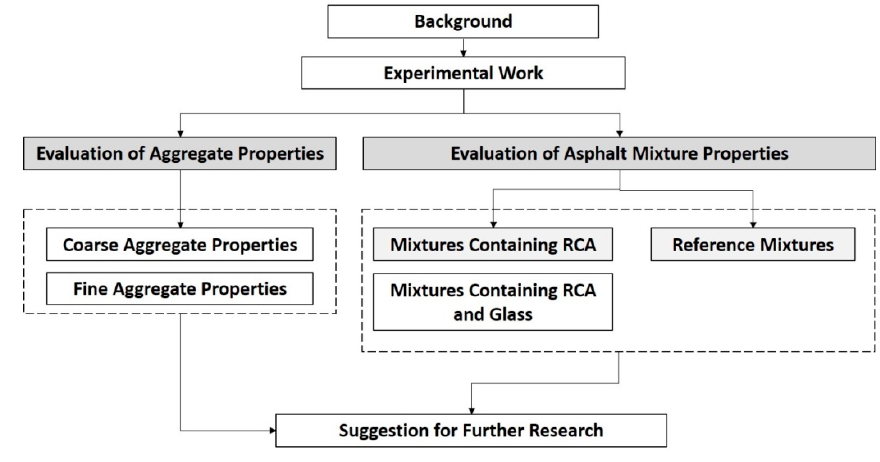
Figure 1. The flowchart of discussion in this research work.